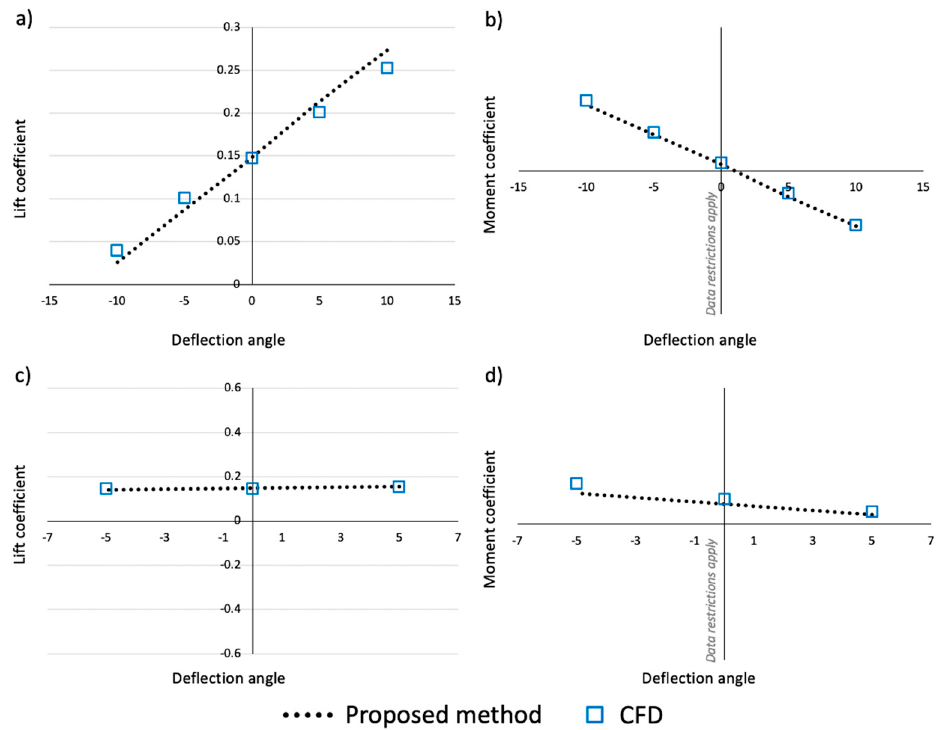
Figure 13. Lift and moment coefficients versus elevon ( a , b ) and ruddervator ( c , d ) deflection angle for 0 degrees of angle of attack.